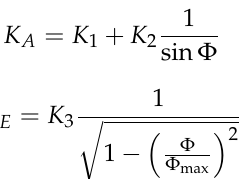
Figure 7. Different target positions. Ten different target locations, i.e., T1–T10, were selected from regions II, III, and IV (T1–T3 are located in region II, T4–T9 are located in region III, and T10 is located in region